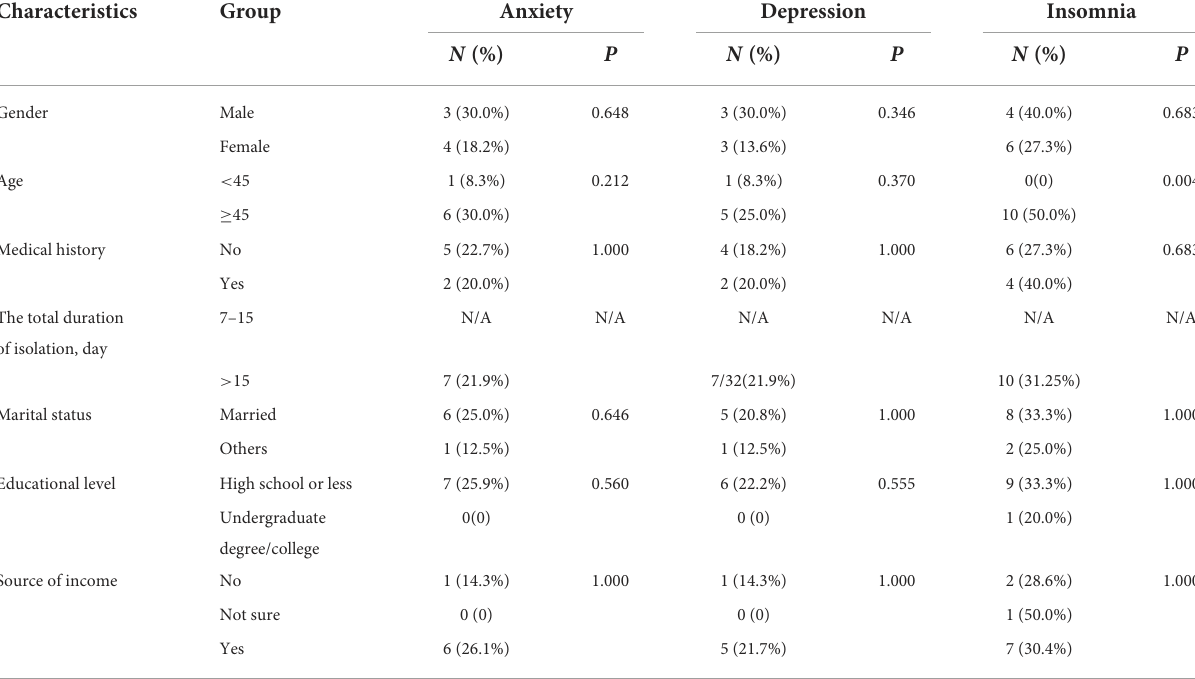
TABLE 3 The demographic distribution of psychological symptoms among re-positive confirmed COVID-19 patients ( N = 32).